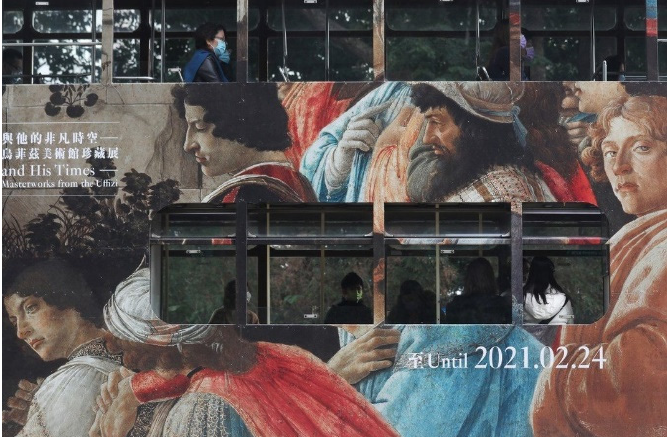
Figure 8. People travel on a tram covered in an ad for the Botticelli and His Times exhibition at the Hong Kong Museum of Art, December 2020, image courtesy of Xiaomei Chen. As part of the Hong Kong Jockey Club Series, the Hong Kong Museum of Art collaborated with the Uffizi Galleries in Florence to bring and exhibit a total of 42 Renaissance-era masterpieces. Botticelli’s work is prominently shown with other Renaissance painters, such as Filippo Lippi and Piero del Pollaiolo.